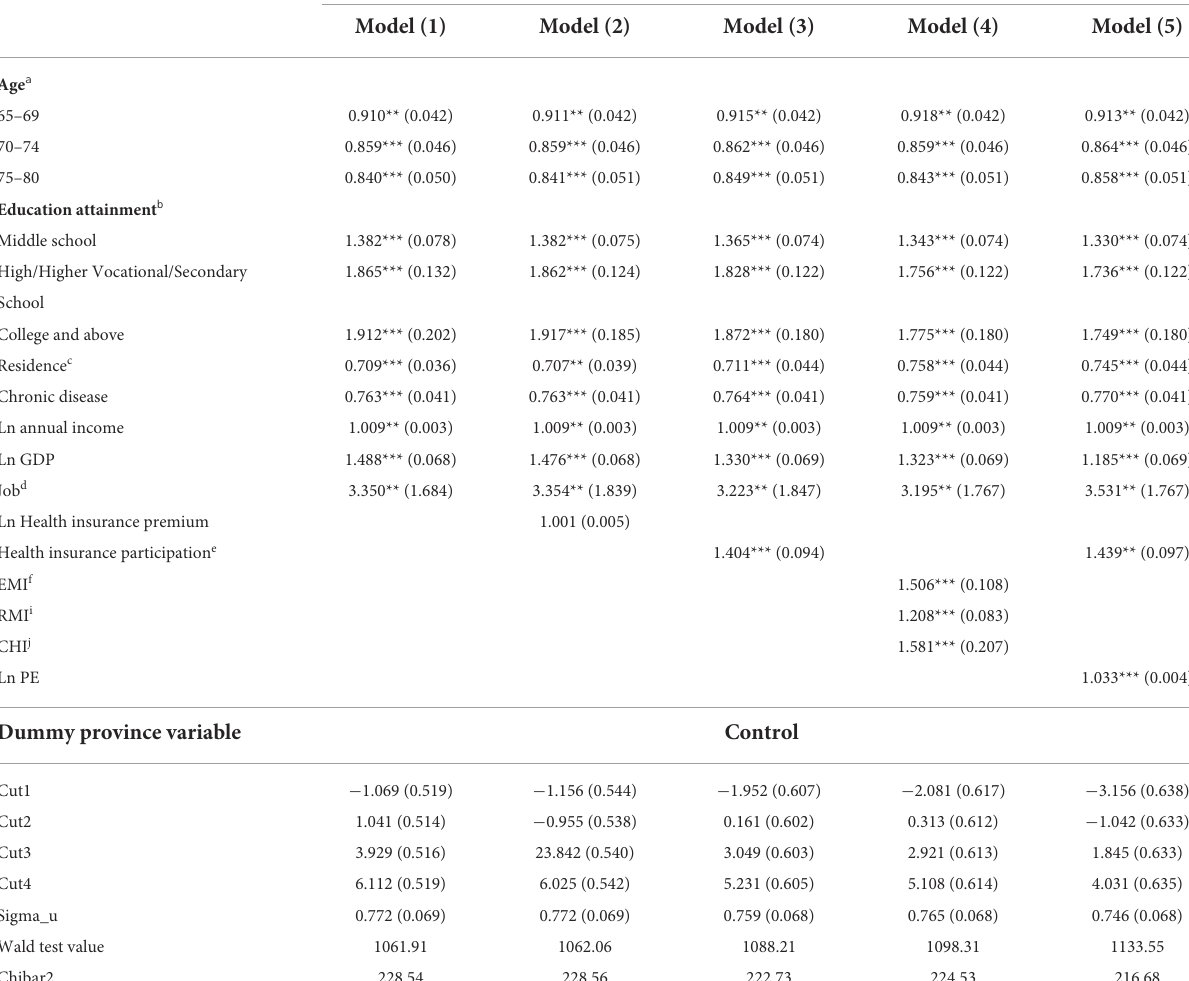
TABLE 2 Results of randomized ordered logistic regression of factors influencing older people’s life satisfaction ( n =